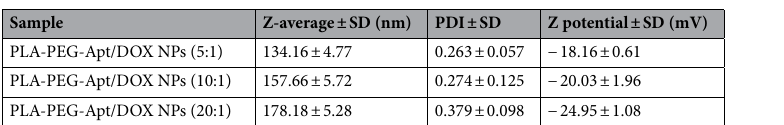
Table 1. Size, zeta potential and PDI of PLA-PEG-Apt/DOX NPs.